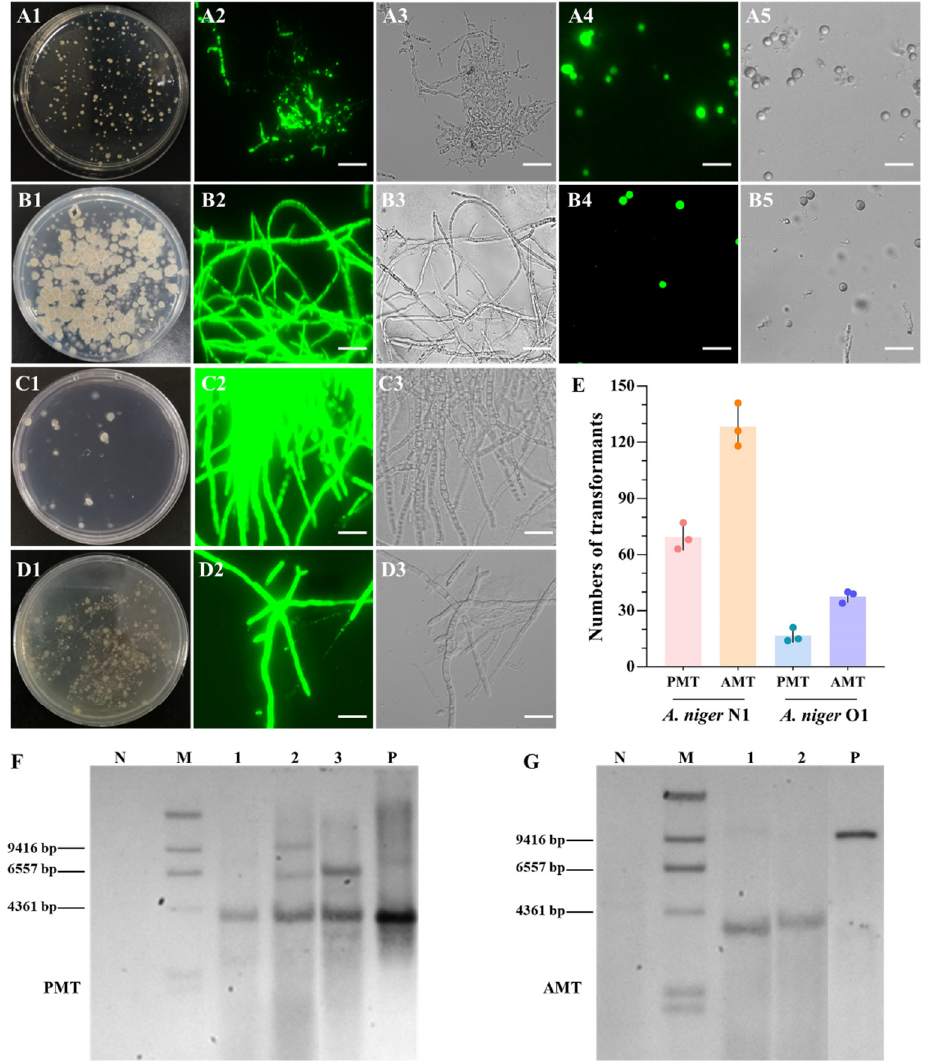
Figure 6. Confirmation of A. niger N1 and O1 transformants. ( A ) A. niger N1 PMT transformation plate ( A1 ), mycelial fluorescence ( A2 ), mycelia in bright field ( A3 ), conidial fluorescence ( A4 ), and conidia in bright field ( A5 ). ( B ) A. niger N1 AMT transformation plate ( B1 ), mycelial fluorescence ( B2 ), mycelia in bright field ( B3 ), conidial fluorescence ( B4 ), and conidia in bright field ( B5 ). ( C ) A. niger O1 PMT transformation plate ( C1 ), mycelial fluorescence ( C2 ), and mycelia in bright field ( C3 ). ( D ) A. niger O1 AMT transformation plate ( D1 ), mycelial fluorescence ( D2 ), and mycelia in bright field ( D3 ). ( E ) Numbers of transformants with fluorescence in each transformation plate. ( F ) Southern blot analysis of A. niger N1 PMT transformants. P, the gfp – neo cassette fragment digested with Xho I as a positive control (expected product of 3908 bp); lanes 1–3, transformants obtained by PMT. ( G ) Southern blot analysis of A. niger N1 AMT transformants. P, the pPK2- hph - gfp plasmid digested with EcoR V as a positive control (expected product of 10,209 bp); lanes 1–2, transformants obtained by AMT. N, genomic DNA from untransformed A. niger N1 as a negative control; M, DNA Molecular-Weight Marker II. Scale bars in panels A–D, 20 µm.